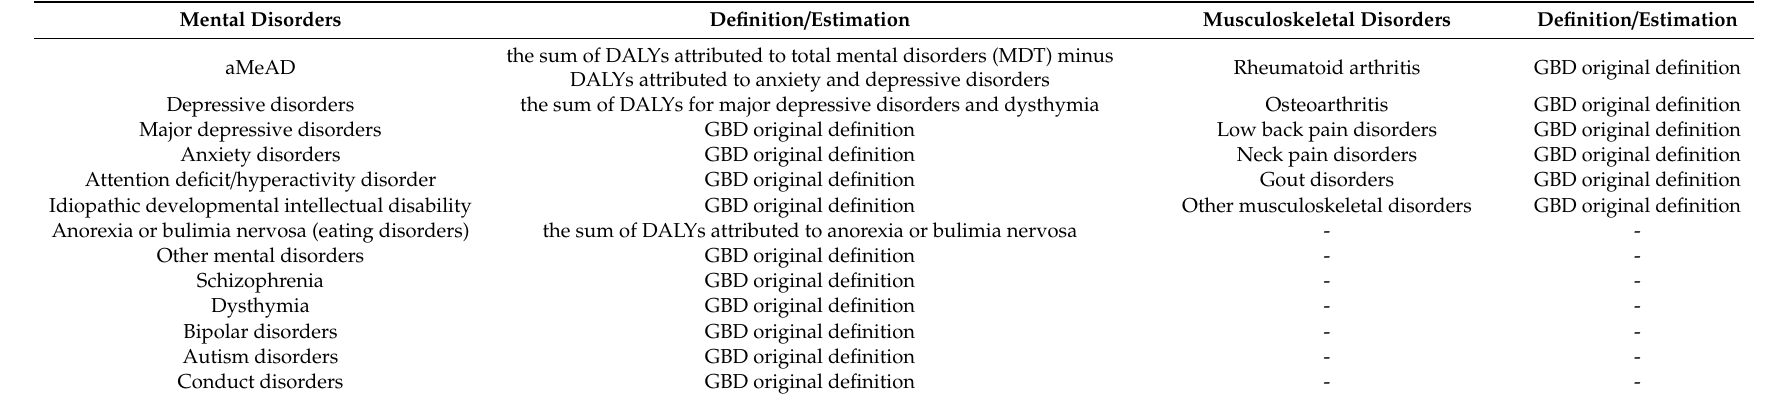
Table 1. Mental and musculoskeletal disorders’ subcategories and